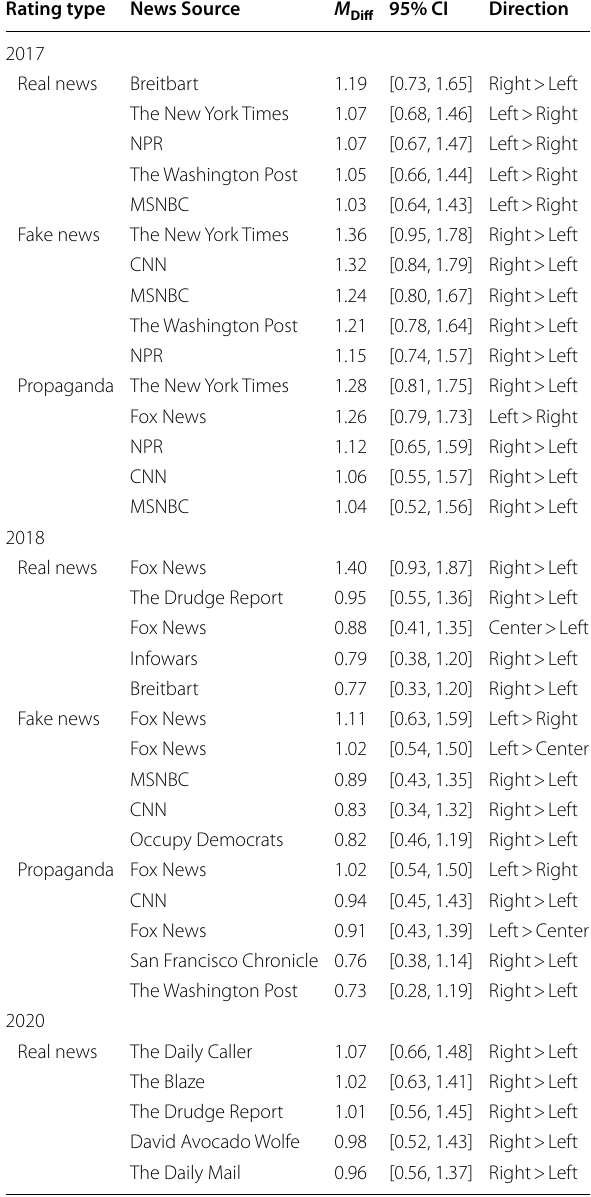
Table 3 Maximum news source rating differences across political